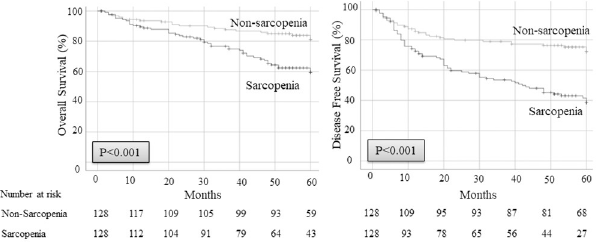
Fig 1. OS and DFS after surgery compared between sarcopenia patients and non-sarcopenia patients. DFS, disease-free survival; OS, overall survival.